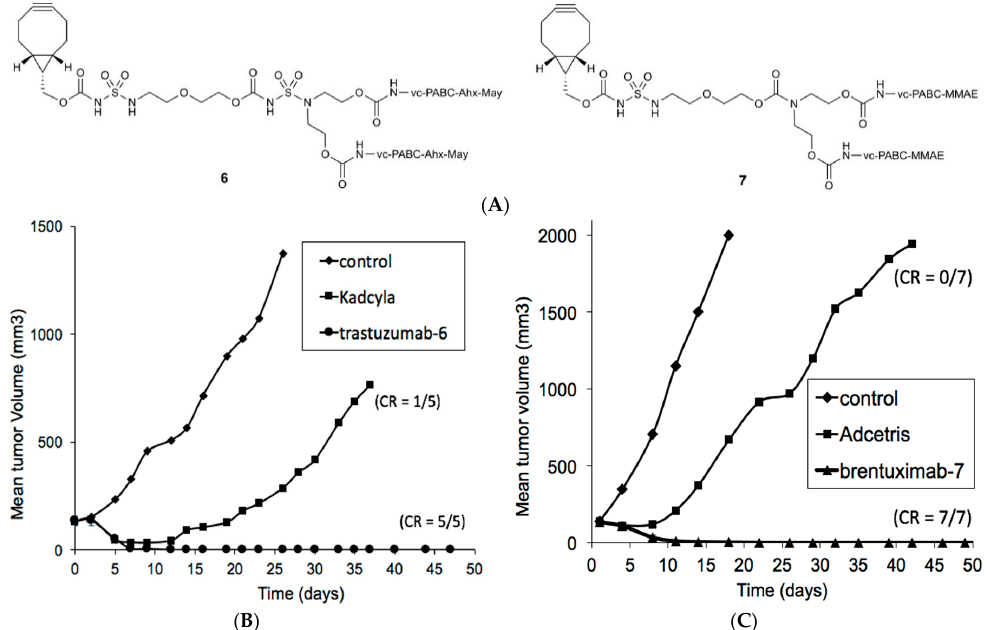
Figure 4. ( A ) Structures of branched HydraSpace™ BCN-payload constructs 6 and 7 ; ( B ) In